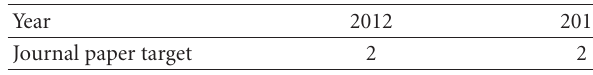
Table 1: Journal